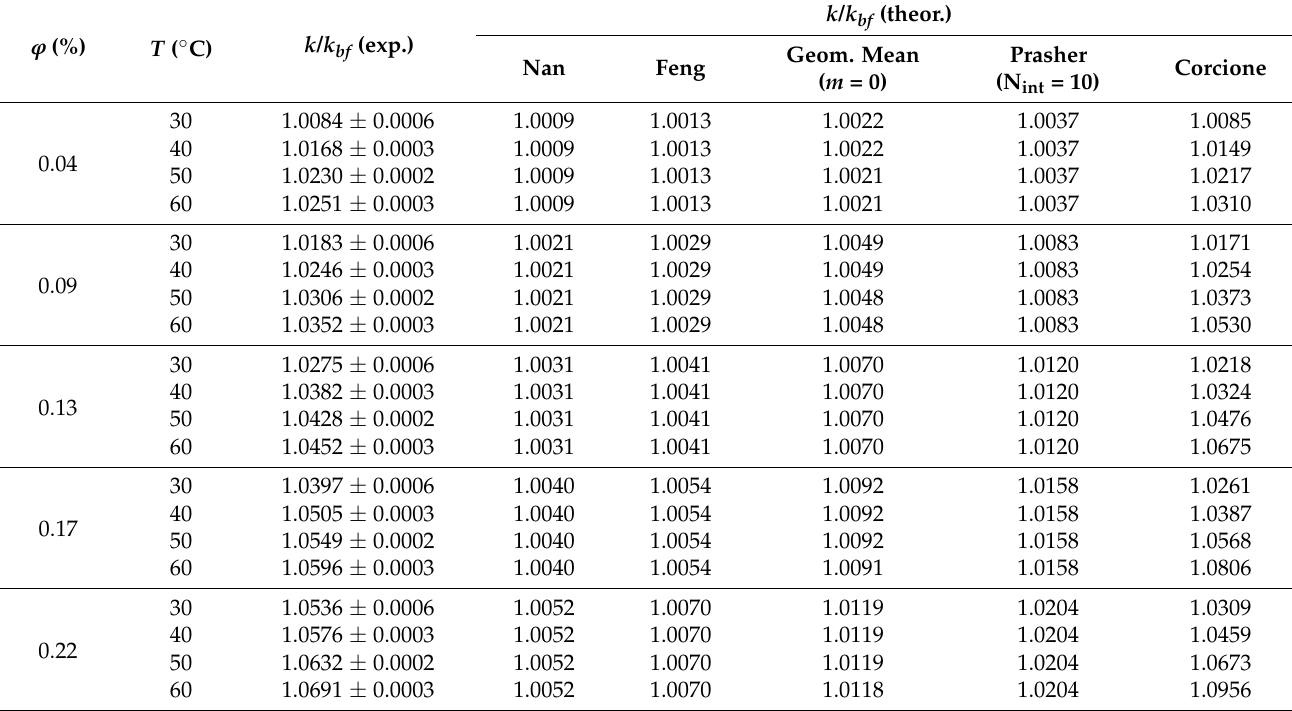
Table 8. Comparison between experimental (SET-II) and theoretical